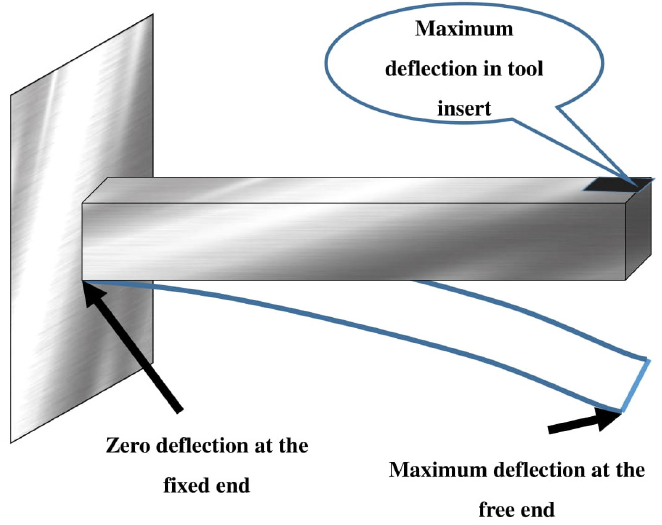
Figure 3. Tool holder as cantilever beam—Finite element method of solving vibrational frequency. Cutting force = F c = 76.564 N Density: Length of the tool holder = L 1 = 10 mm Length of the tool holder = L 2 = 5 mm Height = 10 mm, Width = 10 mm A 1 = Width tool holder × height tool